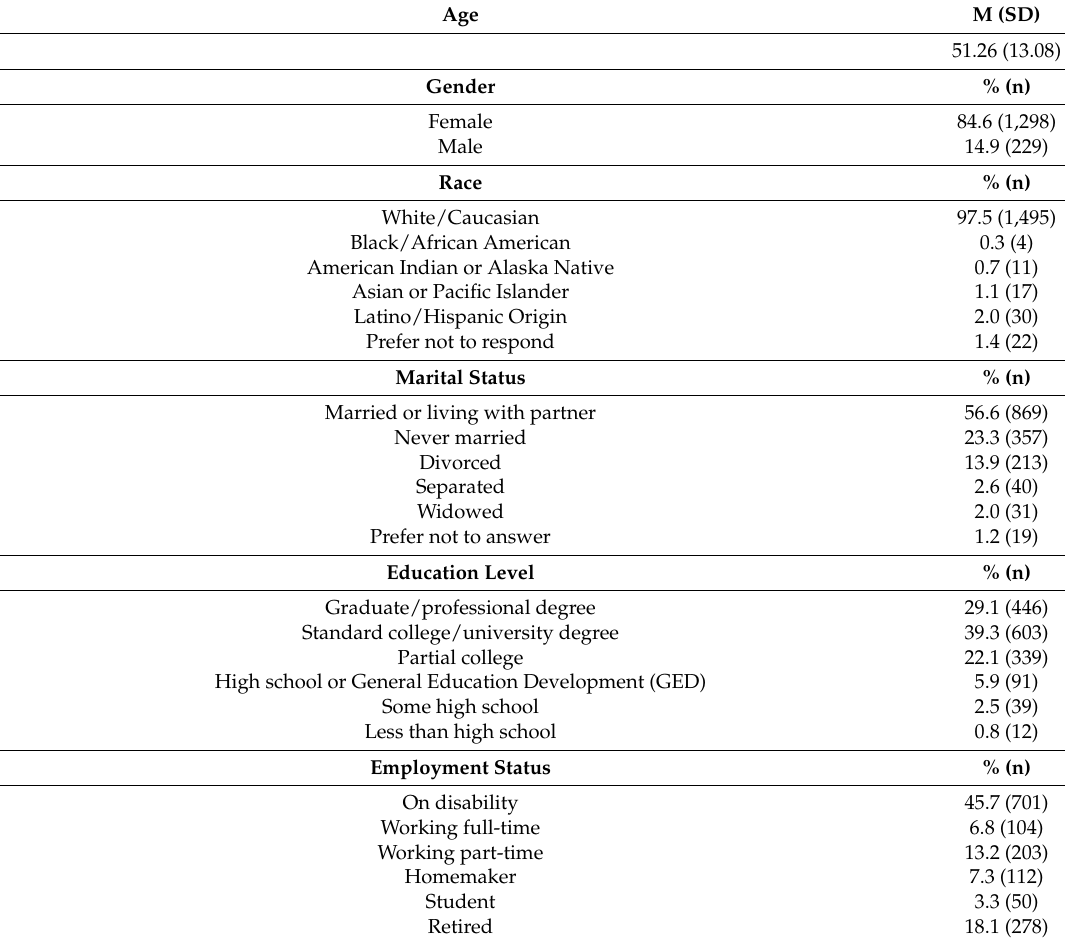
Table 1. Demographic characteristics of patients with myalgic encephalomyelitis (ME) and chronic fatigue syndrome (CFS) ( N =